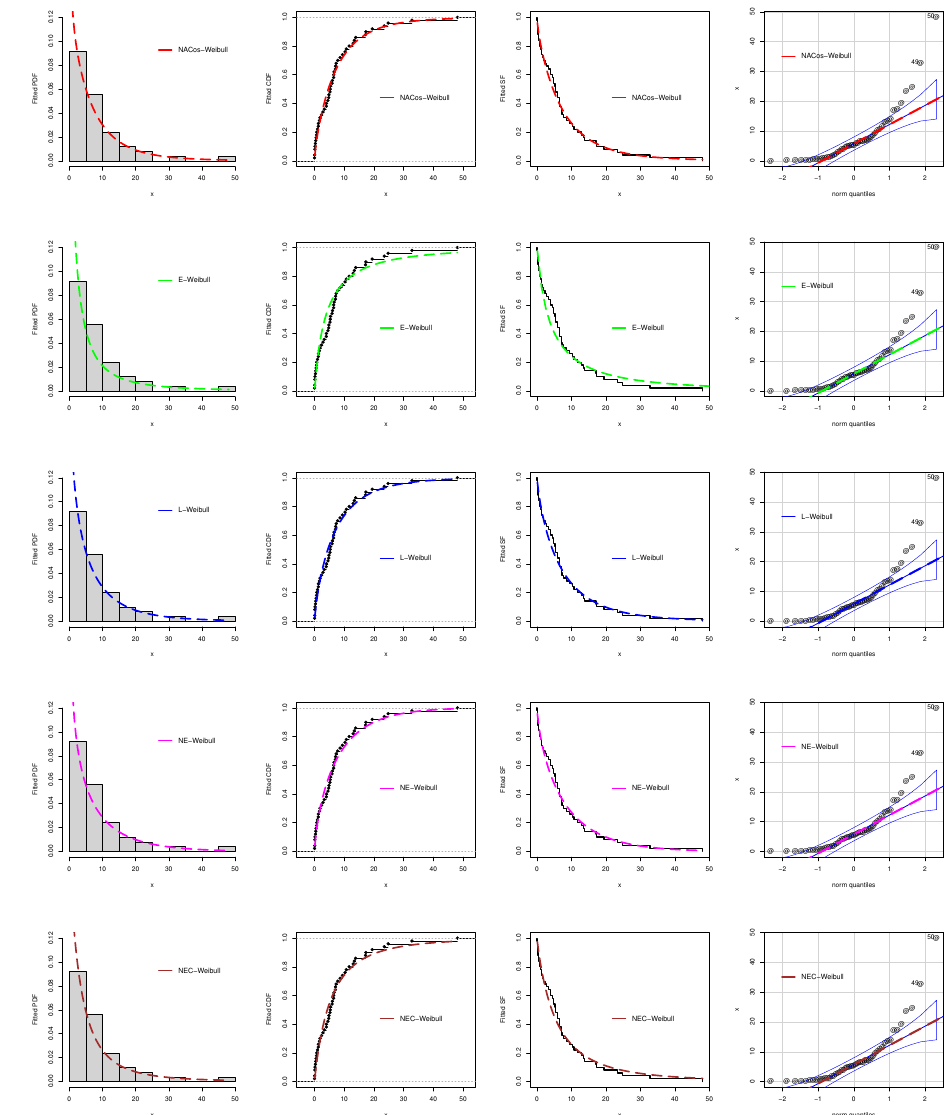
Figure 12. The visual comparison of the fitted models using the failure times data